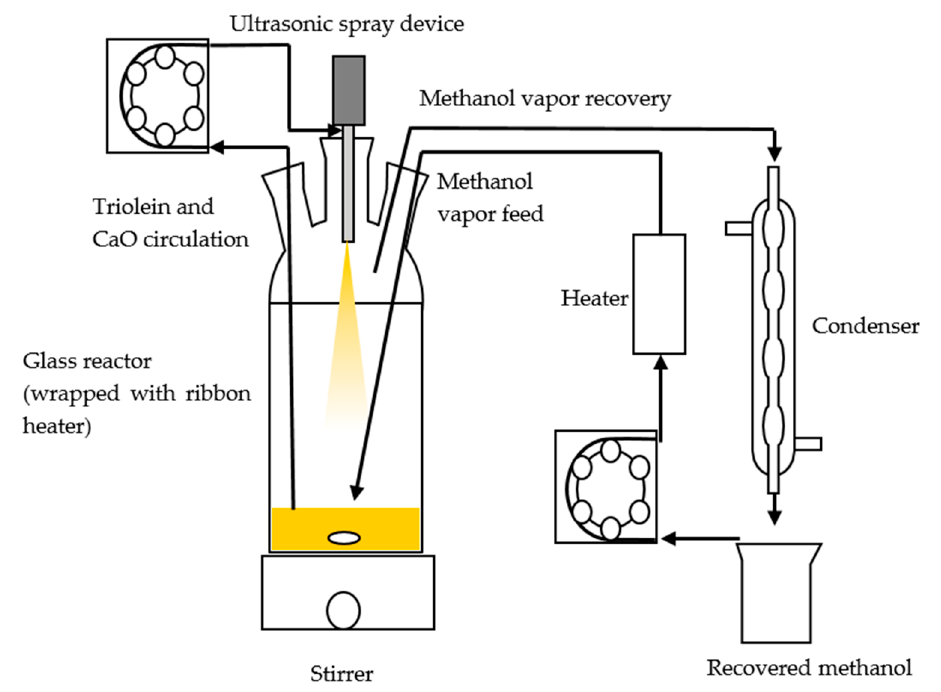
Figure 1. Schematic of the experimental apparatus with the three-phase reactor.